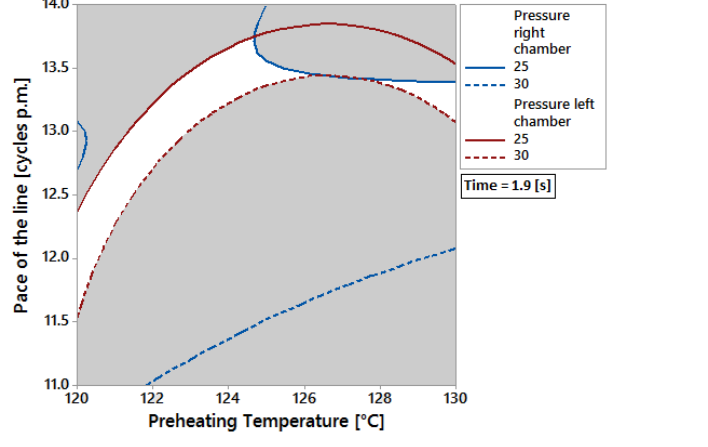
Figure 13 – Overlaid contour plot of Pressure of right chamber and left chamber vs. Pace of the line and Preheating temperature. Interval of response from 25% to